Question: What kind of plot is shown here?
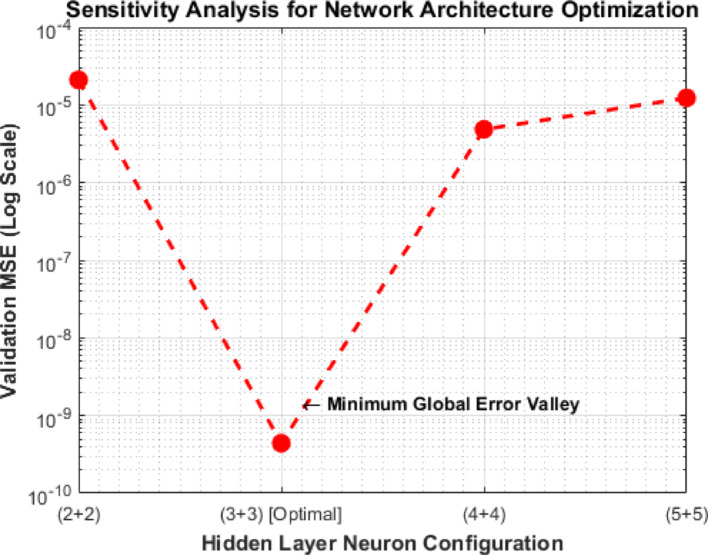
Answer: line